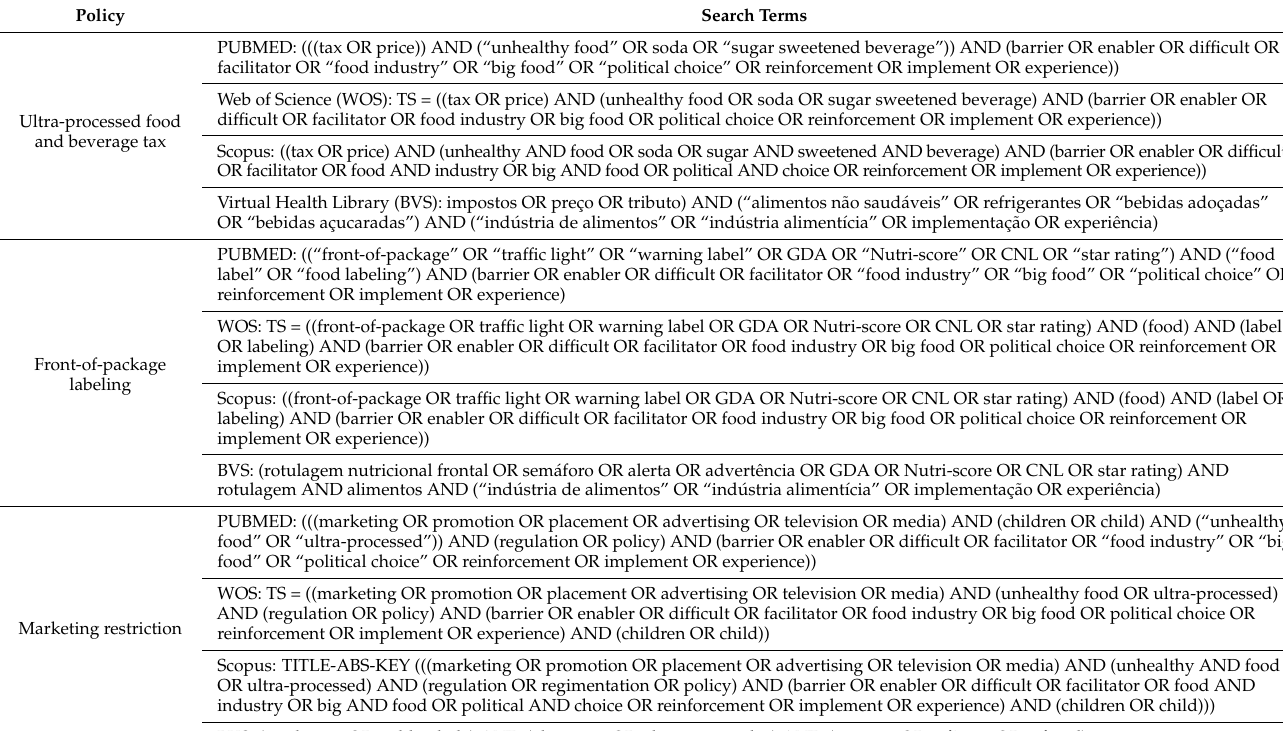
Table 1. Search terms used by studied policy and database.